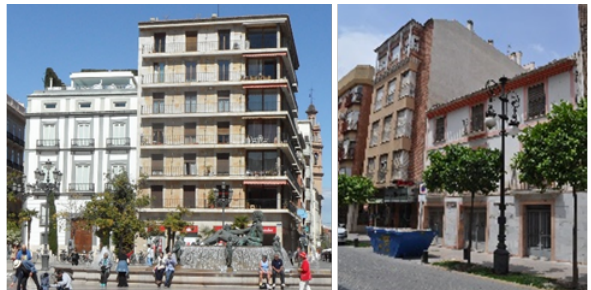
Figure 1. Differences in height (credit: the authors).